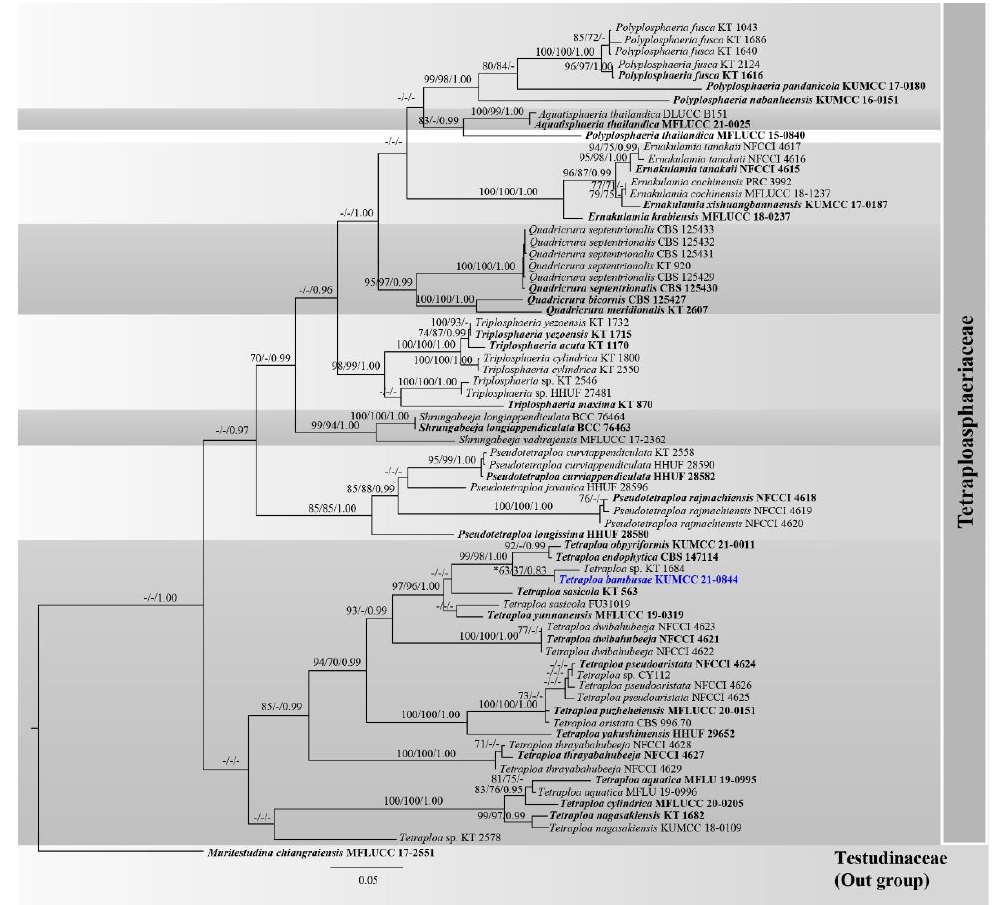
Figure 4. Phylogram generated from RAxML analysis of a concatenated LSU-ITS-SSU- tub2 - tef1- α sequence dataset to represent the phylogenetic relationships of the novel taxon in Tetraploasphaeri- aceae. Bootstrap support values for ML and MP equal to or greater than 70% and the Bayesian posterior probabilities equal to or higher than 0.95 PP are indicated above the nodes as ML/MP/PP. Support values lower than 70% ML/MP and 0.95 PP are indicated by a hyphen (-). Ex-type strains are in bold, and the new species is indicated in blue.